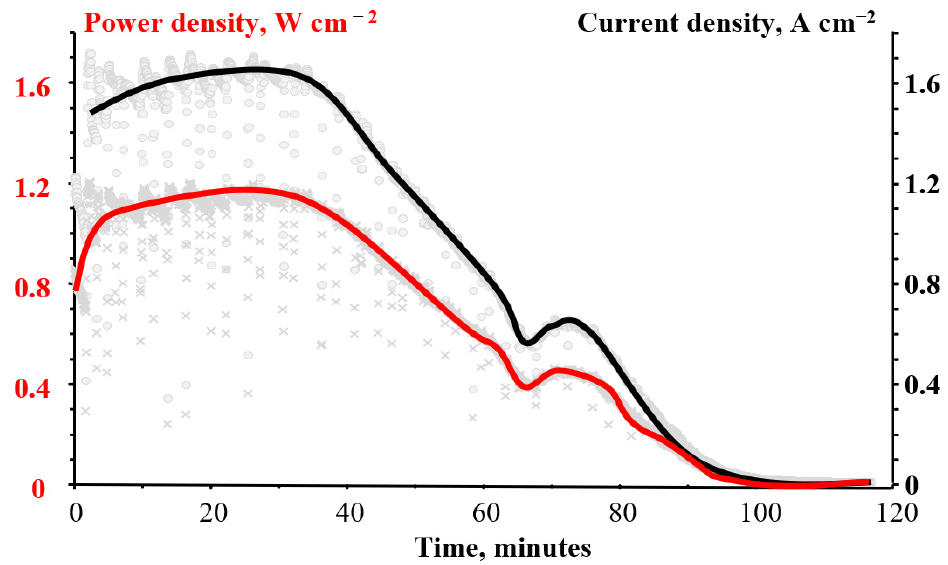
Figure 9. Time example of the variation of current and power densities of a flow cell with a N211 membrane. For both graphs, the solid line is the approximated value of chaotic momentary fluctuations (pale gray points and crosses, correspondingly).